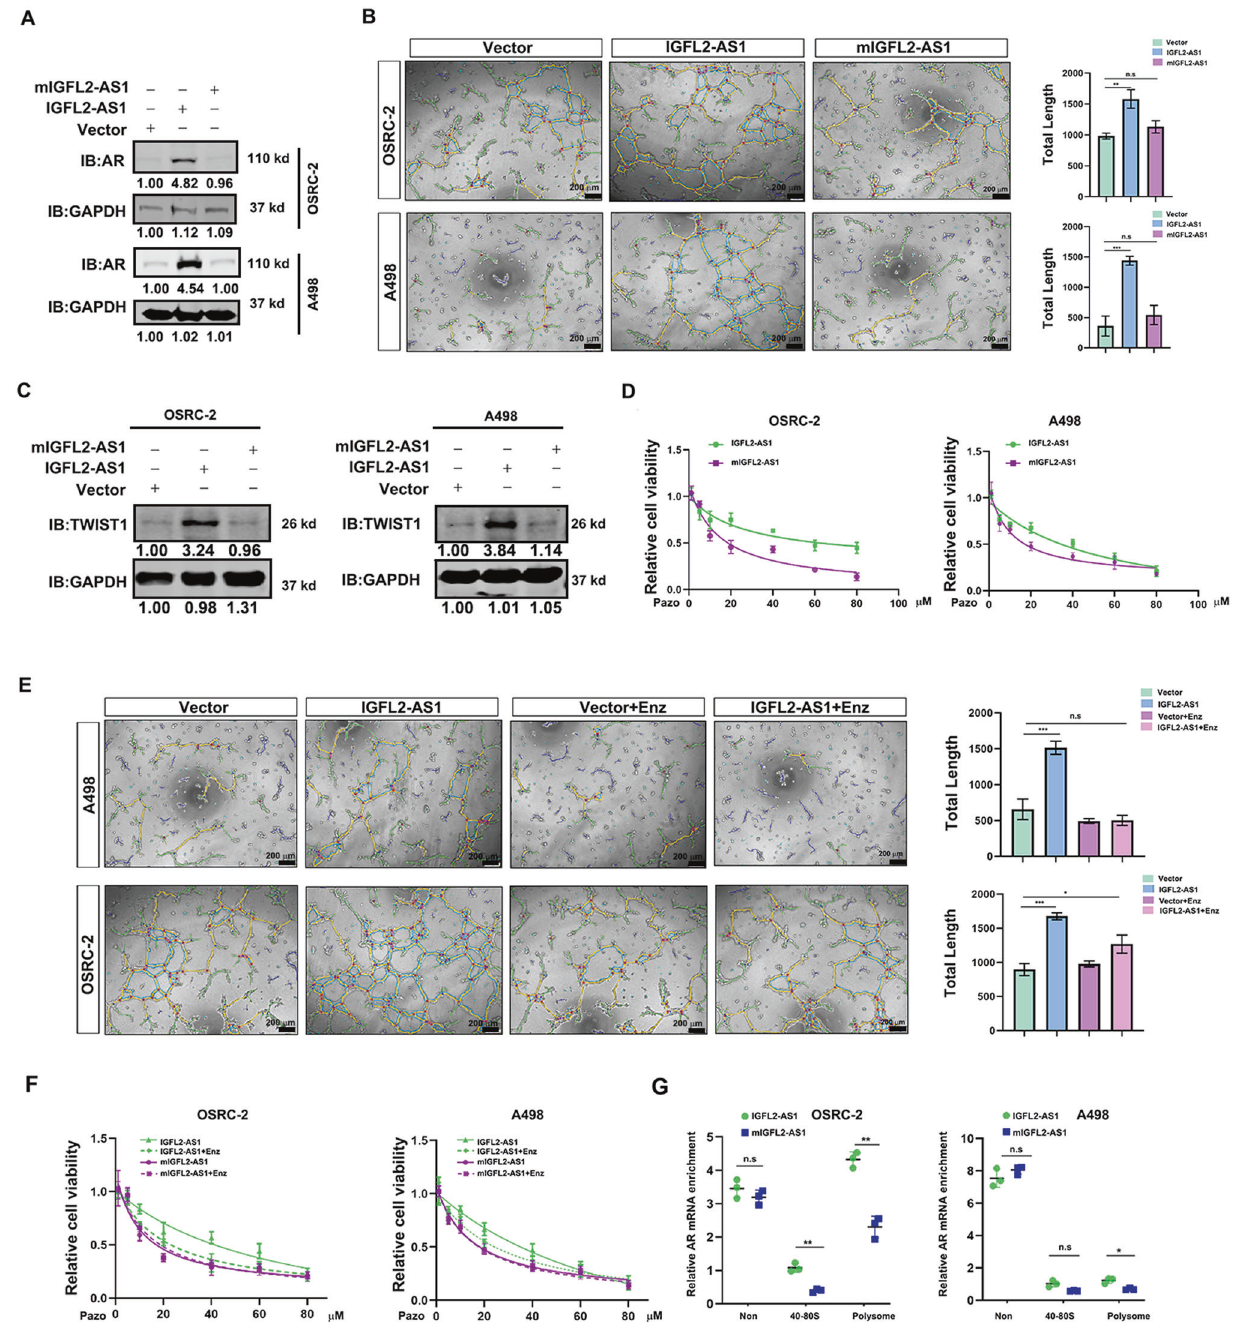
Fig. 4 The contributions of IGFL2-AS1 to ccRCC VM formation and pazopanib resistance requires its binding to AR mRNA. A Wild type IGFL2-AS1 but not mutated one increased AR expression in A498 and OSRC-2 cells. GAPDH was normalizing control. B Wild type IGFL2-AS1 but not mutated one increased VM development of A498 and OSRC-2 cells. Left, representative images. Right, statistical analyses. Scale bar: 200 μ m. C Wild type IGFL2-AS1 but not mutated one increased TWIST1 expression in A498 and OSRC-2 cells. GAPDH was loading control. D Wild type IGFL2-AS1 had stronger ability to promote pazopanib resistance of A498 and OSRC-2 cells than the mutated one. E Enzalutamide treatment attenuated IGFL2-AS1 induced VM development in A498 and OSRC-2 cells. Left, representative images. Right, statistical analyses. Scale bar: 200 μ m. F Enzalutamide treatment abolished IGFL2-AS1 induced pazopanib resistance of ccRCC cells. G Wild type IGFL2-AS1 had stronger ability to promote AR translation than mutated one, monitored by polysome pro fi ling assay. * P < 0.05; ** P < 0.01; *** P < 0.001, n.s = no signi fi